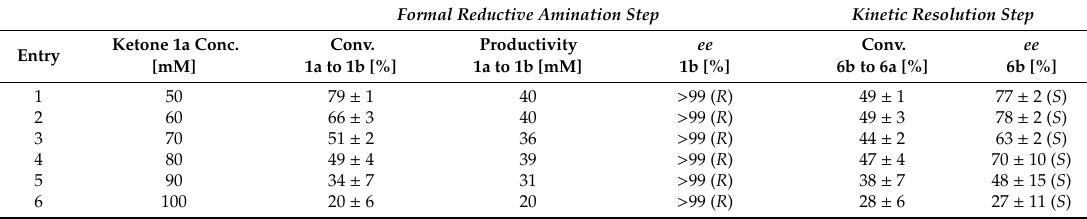
Table A3. PIKAT of 1a with rac - 6b using higher concentrations of 1a (50–100 mM) in order to possibly thermodynamically push the kinetic resolution of rac - 6b to